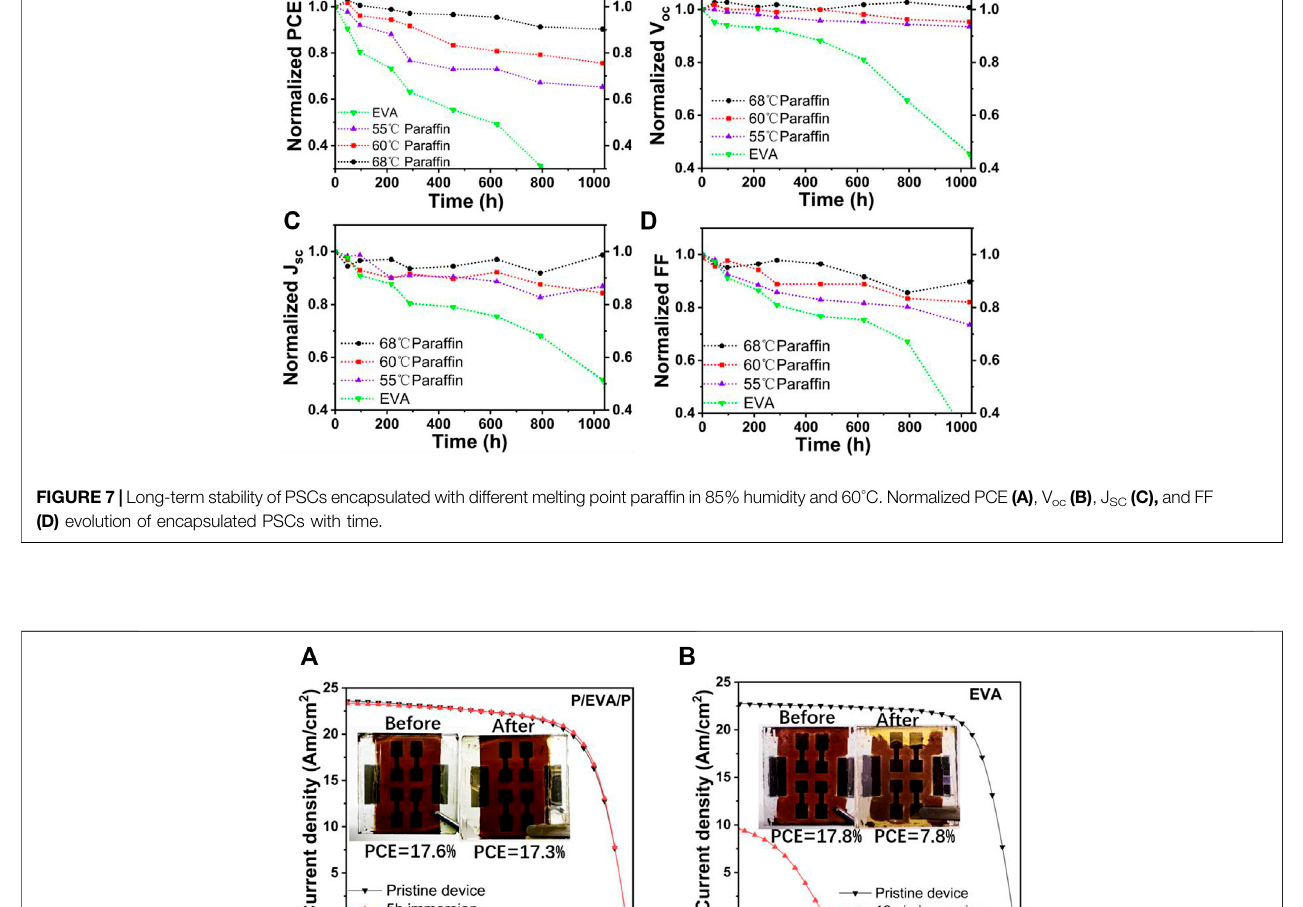
FIGURE 8 | J – V curves and photos of PSCs with paraf fi n/EVA/paraf fi n before and after immersing in water for 5 h (A) . J − V curves and photos of PSCs with EVA before and after immersing in water for 10 min (B) .